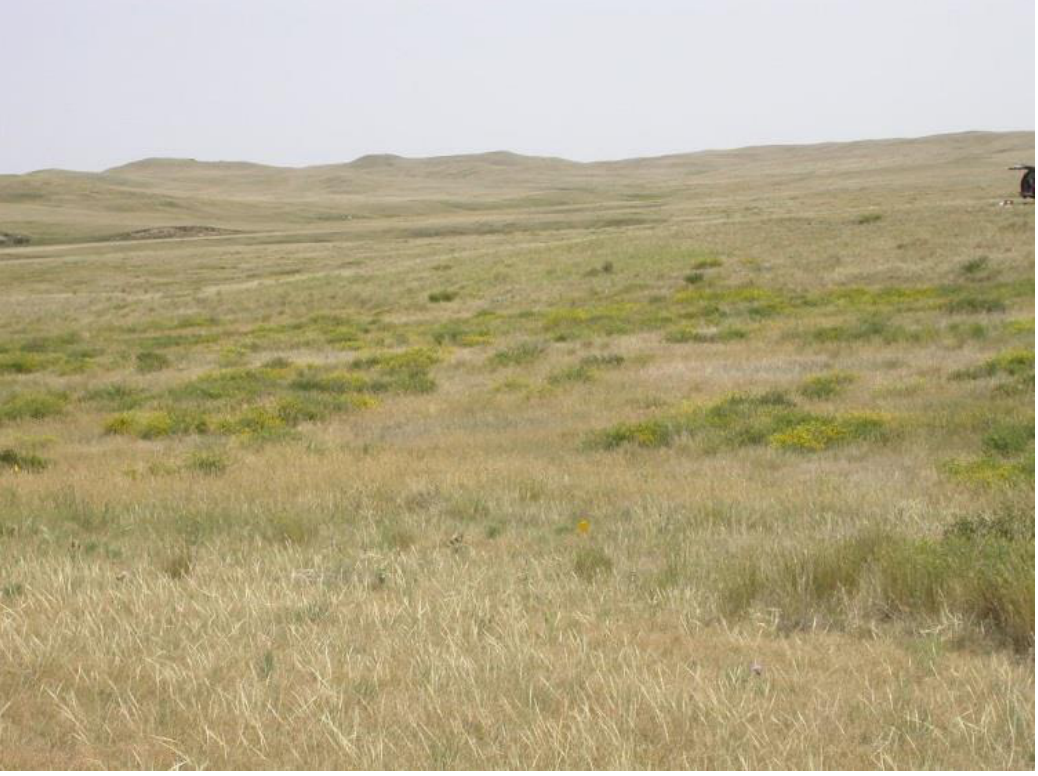
Figure 1. Yellow-flowered alfalfa in full bloom on the Grand River National Grassland near Lodgepole, South Dakota (45°45′42″ N, 102°40′25″ W).